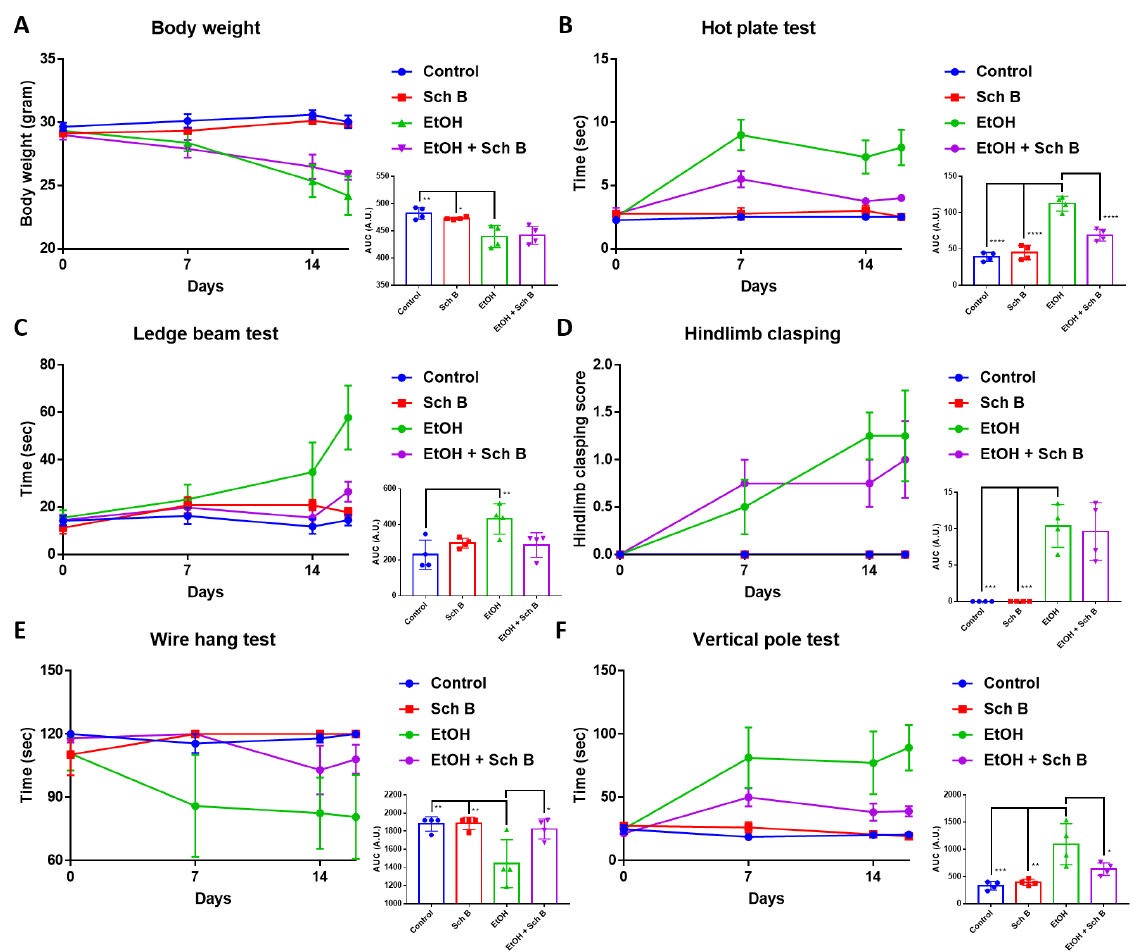
Figure 4. Schisandrin B prevents neurological function defects in mice consuming ethanol. ( A ) Mouse body weight. Assessment of neurological functions in mice by the ( B ) hot plate, ( C ) ledge beam, ( D ) hindlimb clasping, ( E ) wire hang, and ( F ) vertical pole tests. n = 4 mice. Results are expressed as mean ± standard error mean (SEM), and area under the curve (AUC) values are expressed as mean ± SD. * p < 0.05, ** p < 0.01, *** p < 0.001, and **** p < 0.0001.